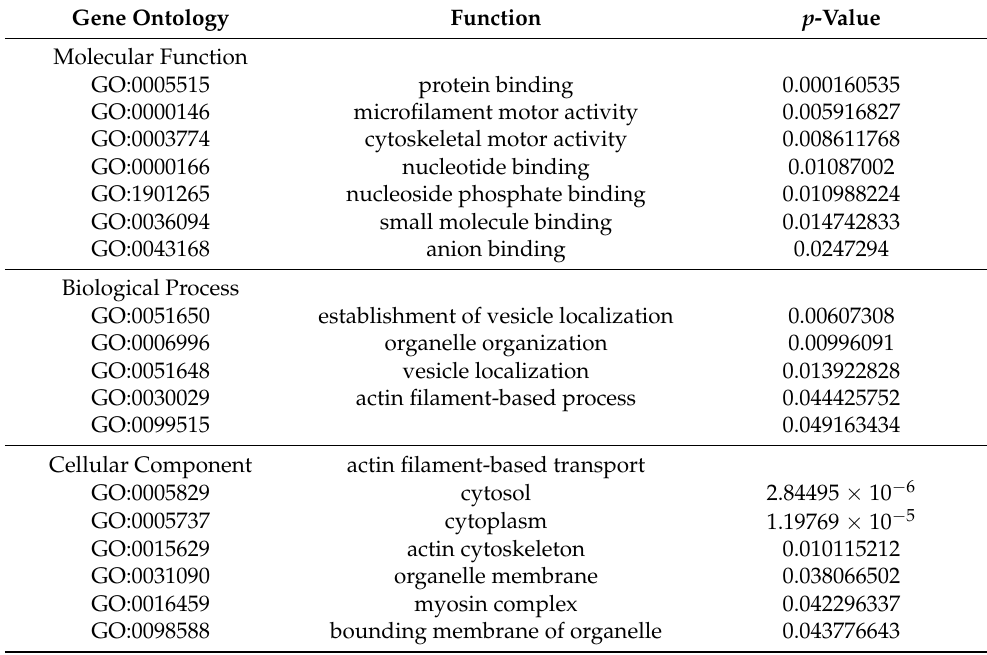
Table 3. Gene ontology analysis of LOC550643-coexpression genes in colon cancer from TCGA